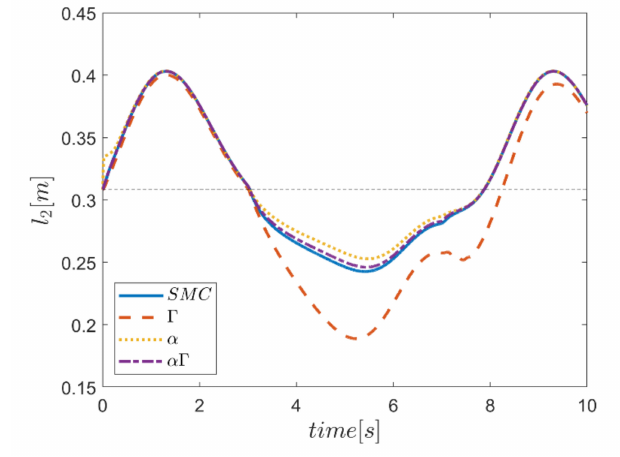
Figure 57. Comparison of the length of the second actuator.